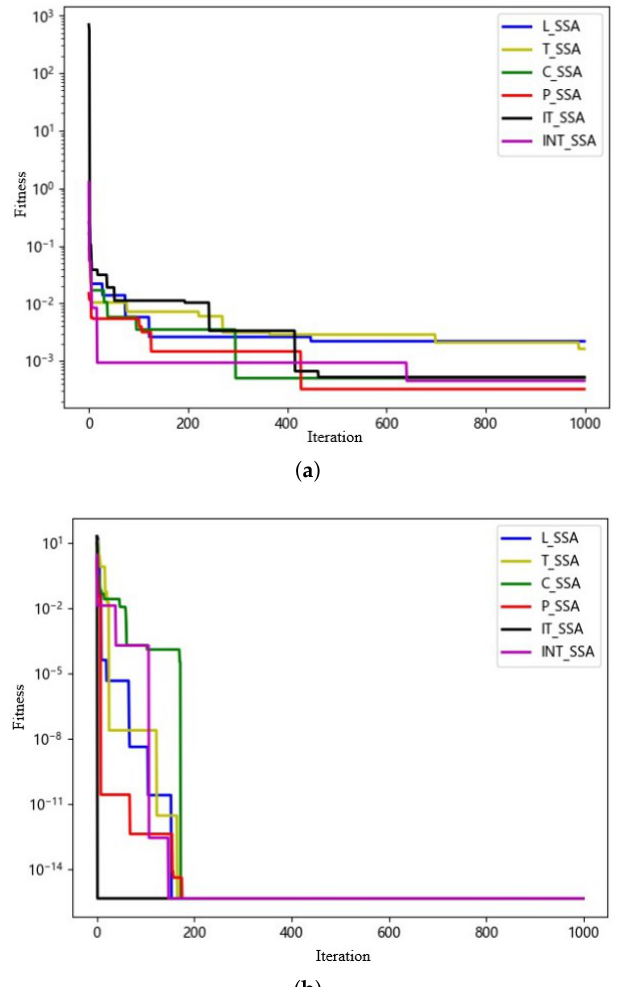
Figure 2. Iteration curves of 6 chaotic mapping improved SSA algorithms for different types of test functions, ( a ) for high-dimensional single-peaked function, ( b ) for high-dimensional multi-peaked